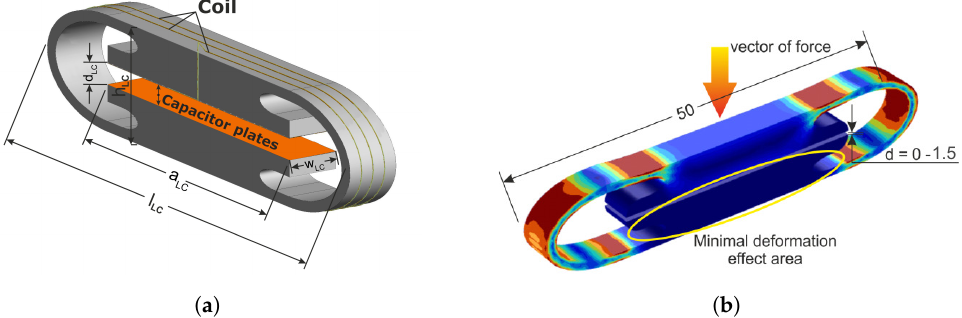
Figure 1. Visualization of the experimental transducer seen in Figure 2 : l LC = 52 mm, h LC = 10.5 mm, w LC = 5.6 mm, a LC = 37 mm, d LC = 1.75 mm (compact compliant mechanical body with inductor and capacitor in parallel). ( a ) Distribution of von Mises stress and ( b ) deformation of the elastic